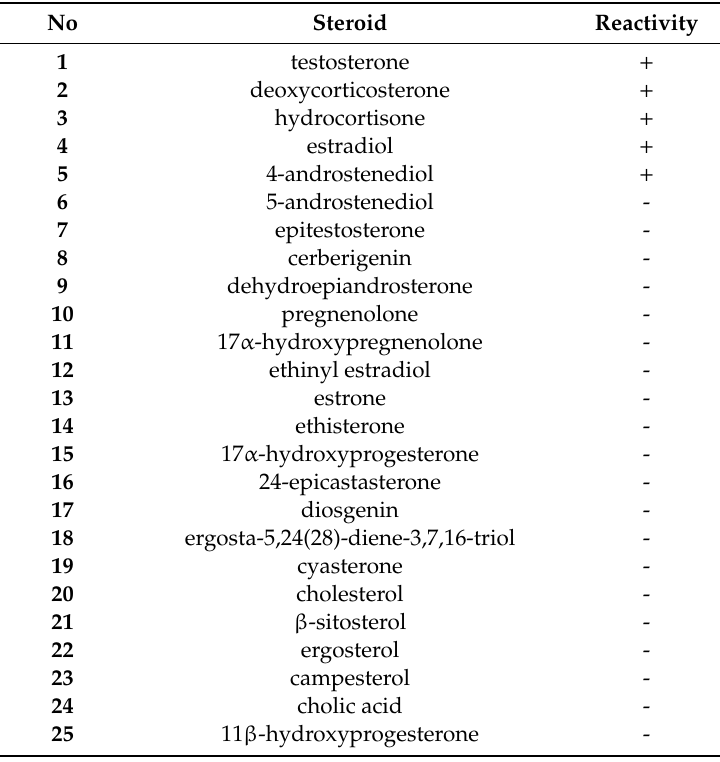
Table 3. Steroids used for OcUGT1-catalyzed glucosylations.